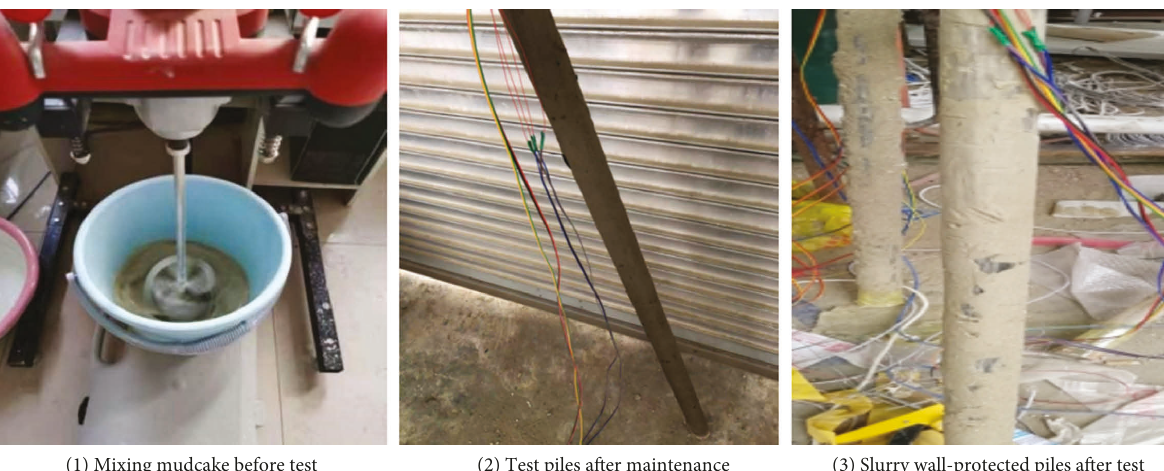
Figure 1: Model piles. (a) Mixing mudcake before test. (b) Test piles after maintenance. (c) Slurry wall-protected piles after test.